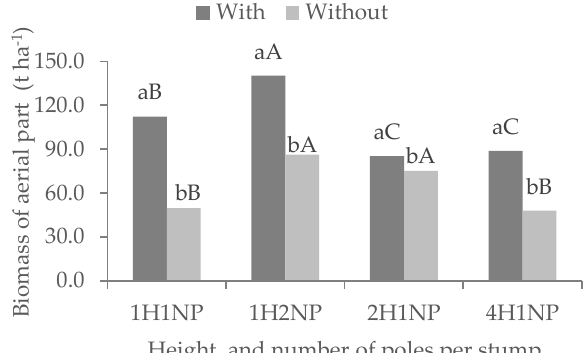
Figure 3. Biomass of wood, trunk and aerial part of the clone GG157, at 60 months of age, influenced by liming/fertilization (With or Without), height (H) and number (NP) of poles per stump at the time of pole selection. Lowercase letters compare the effect of fertilization in the same treatment and uppercase letters compare the effect of the combination between height (H = 1, 2 or 4 m) and number of poles (NP = 1 or 2) left on the stump at the time of pole selection for the same fertilization condition (Tukey at 5%).